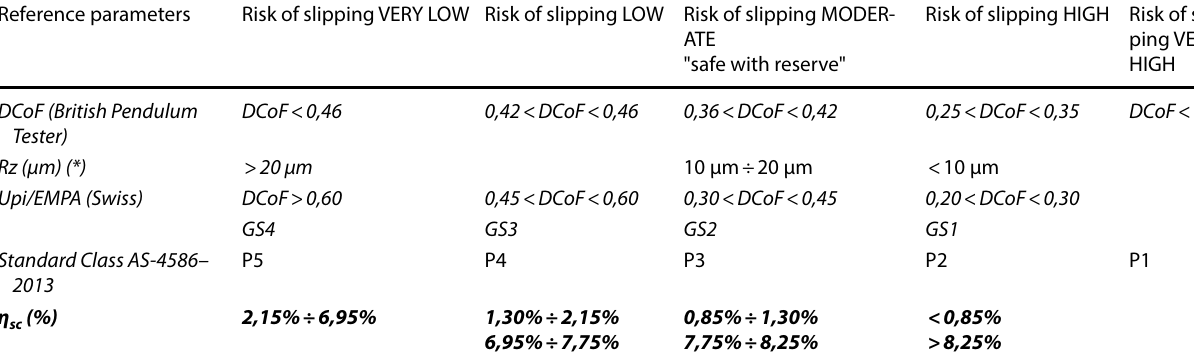
Table 3 Comparison between different classifications of slipping risk indices Reference